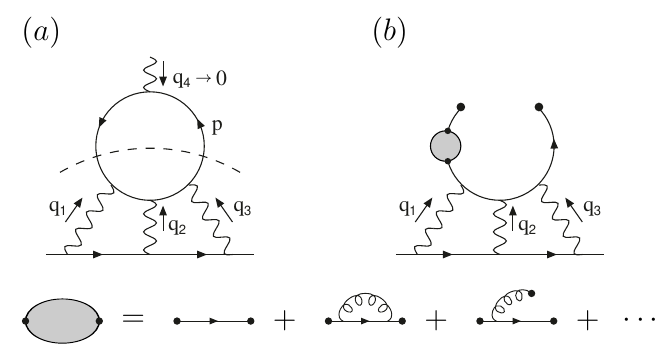
Figure 2 . Example of contributions of HLbL in the studied kinematic region. (a) The quark loop. (b) The di-quark magnetic susceptibility. A complete separation between short-distance and long-distance e(cid:11)ects should subtract possible divergent low-momenta contributions from the quark loop and possible divergent perturbative series arising from soft